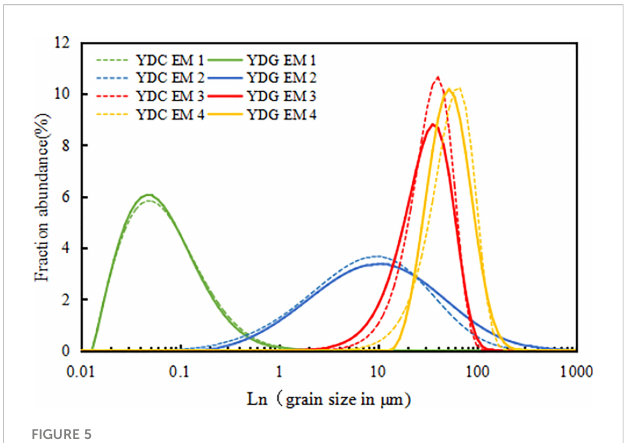
FIGURE 5 Parametric end-member frequency distribution